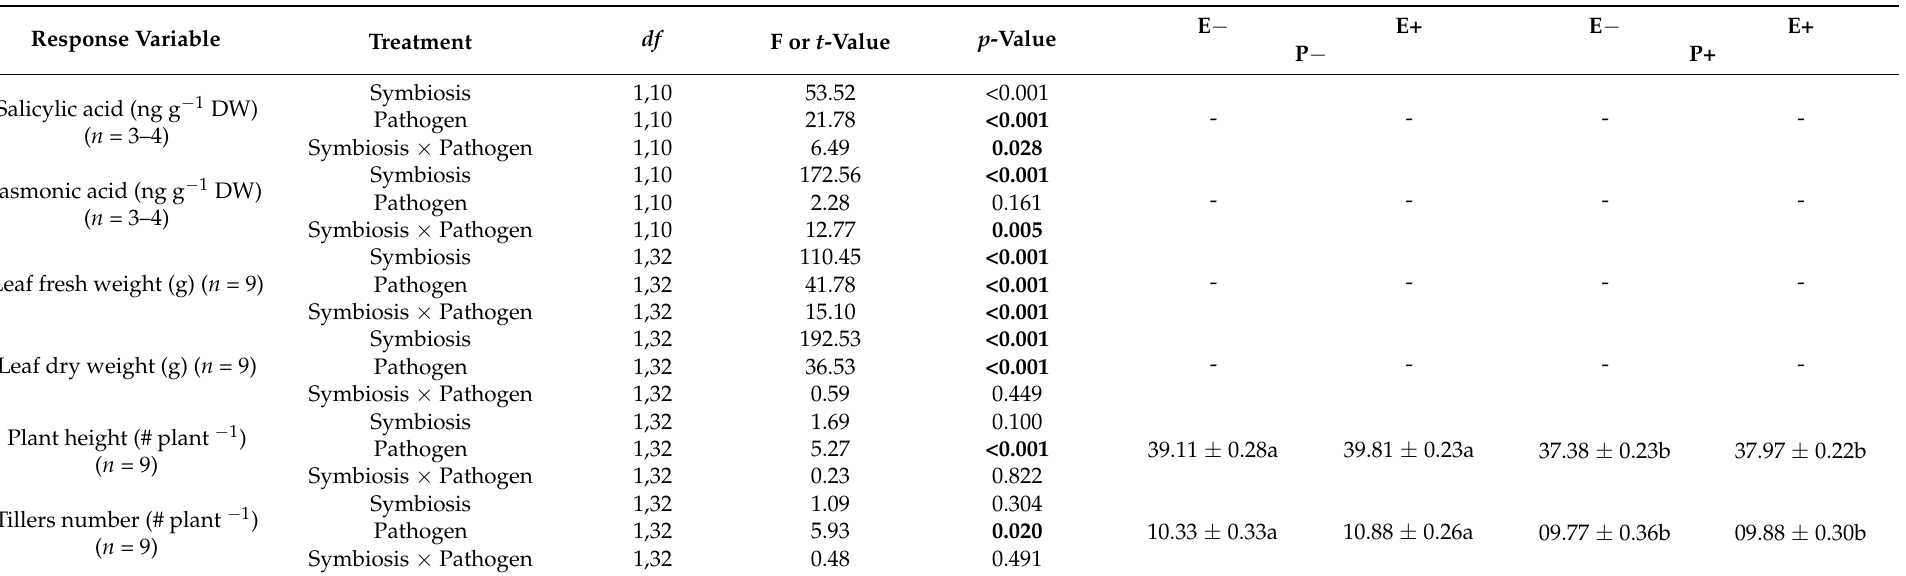
Table 1. ANOVA table showing the effects of plant symbiosis status and pathogen inoculation on the concentration of plant hormones (salicylic acid and jasmonic acid) and plant growth parameters (fresh and dry leaf weights, height and tillers number) of Achnatherum inebrians plants with (E+) and without (E − ) the fungal endophyte Epichloë gansuensis and inoculated (P+) and non-inoculated (P − ) with the pathogen Blumeria graminis . Hormones and plant growth performance variables were measured at four and three weeks, respectively, after the pathogen inoculation of plants. Statistically significant effects are highlighted in bold. Different letters on plant growth performance values indicate significant differences at p < 0.05 (post hoc test). Replicate numbers are indicated in parenthesis. Values are mean ±